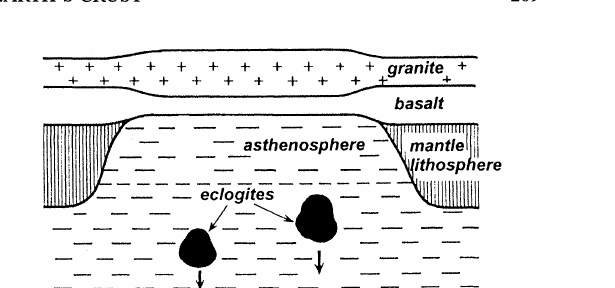
FIGURE 8 Emergence of light asthenosphere to the base of the crust with sinking of dense eclogites into the asthenospheric layer. This produces a strong uplift of the overlying crust and mountain building at the Earth’s